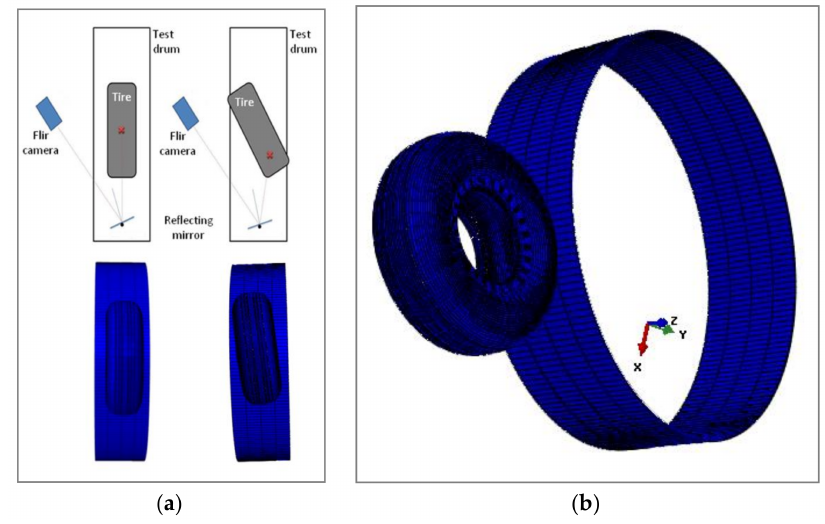
Figure 14. ( a ) The tire position on the drum at skidding angles at 0 ◦ and 6 ◦ , ( b ) numerical simulation, tire/drum